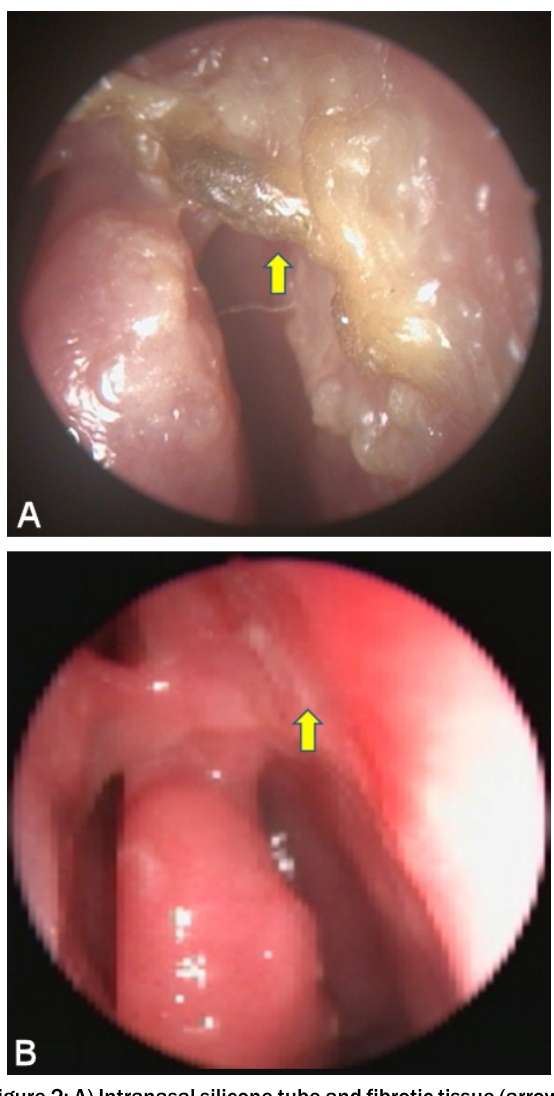
Figure 2: A) Intranasal silicone tube and fibrotic tissue (arrow). B) Intranasal synechia and narrow ostium